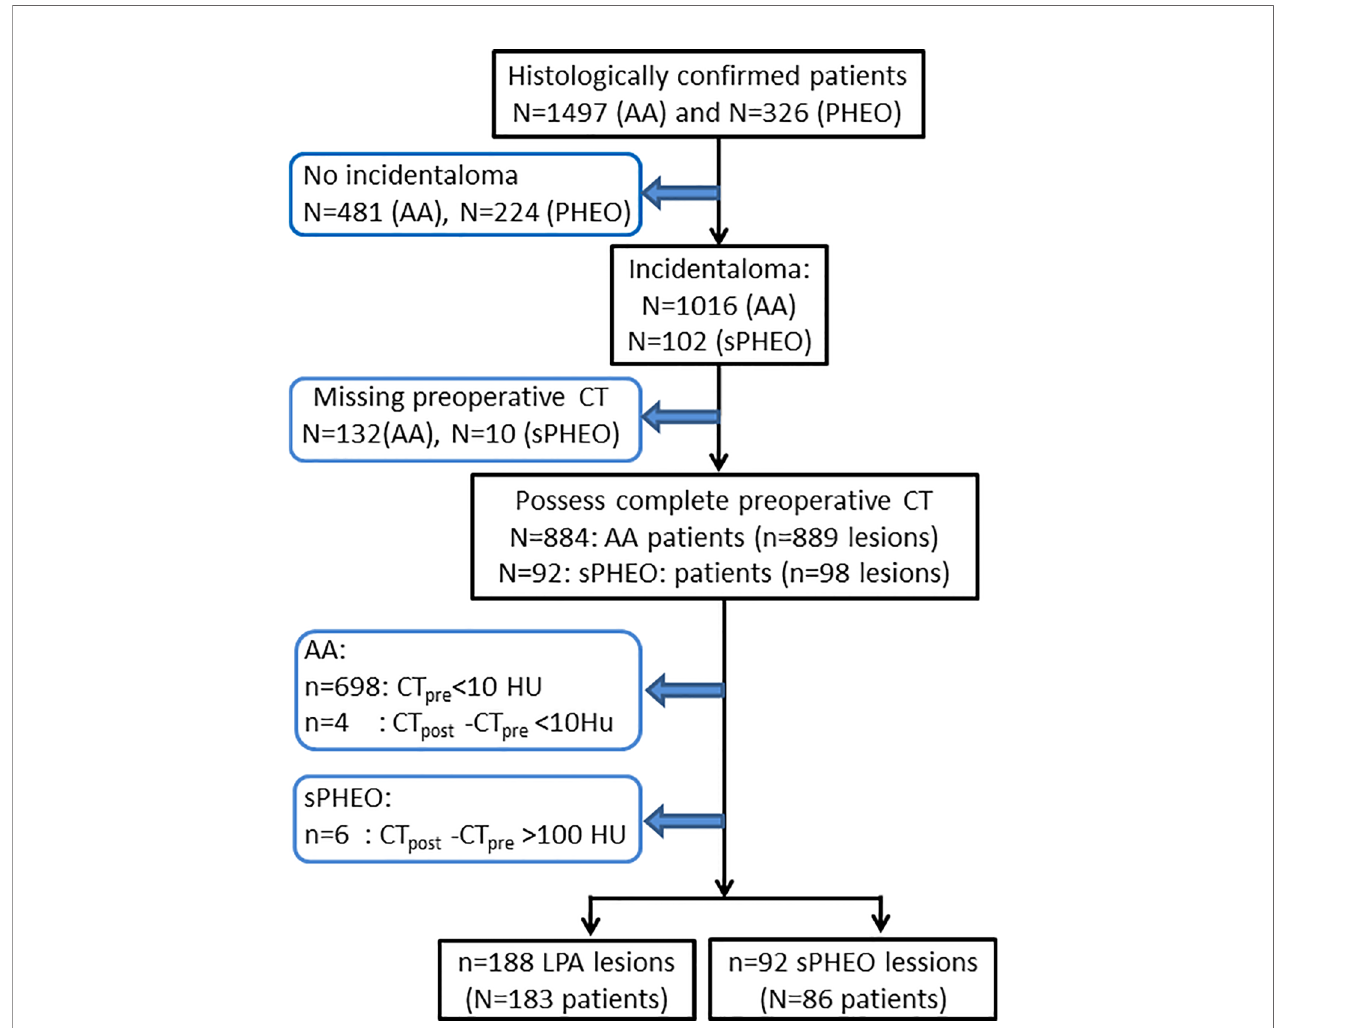
FIGURE 1 | Flow-chart of patient enrollment for this study. CT pre , pre-enhanced CT value; CT post , enhanced CT value; AA, adrenal adenoma; PHEO, pheochromocytoma; sPHEO, subclinical pheochromocytoma; LPA, lipid poor adenoma; HU, Houns fi eld